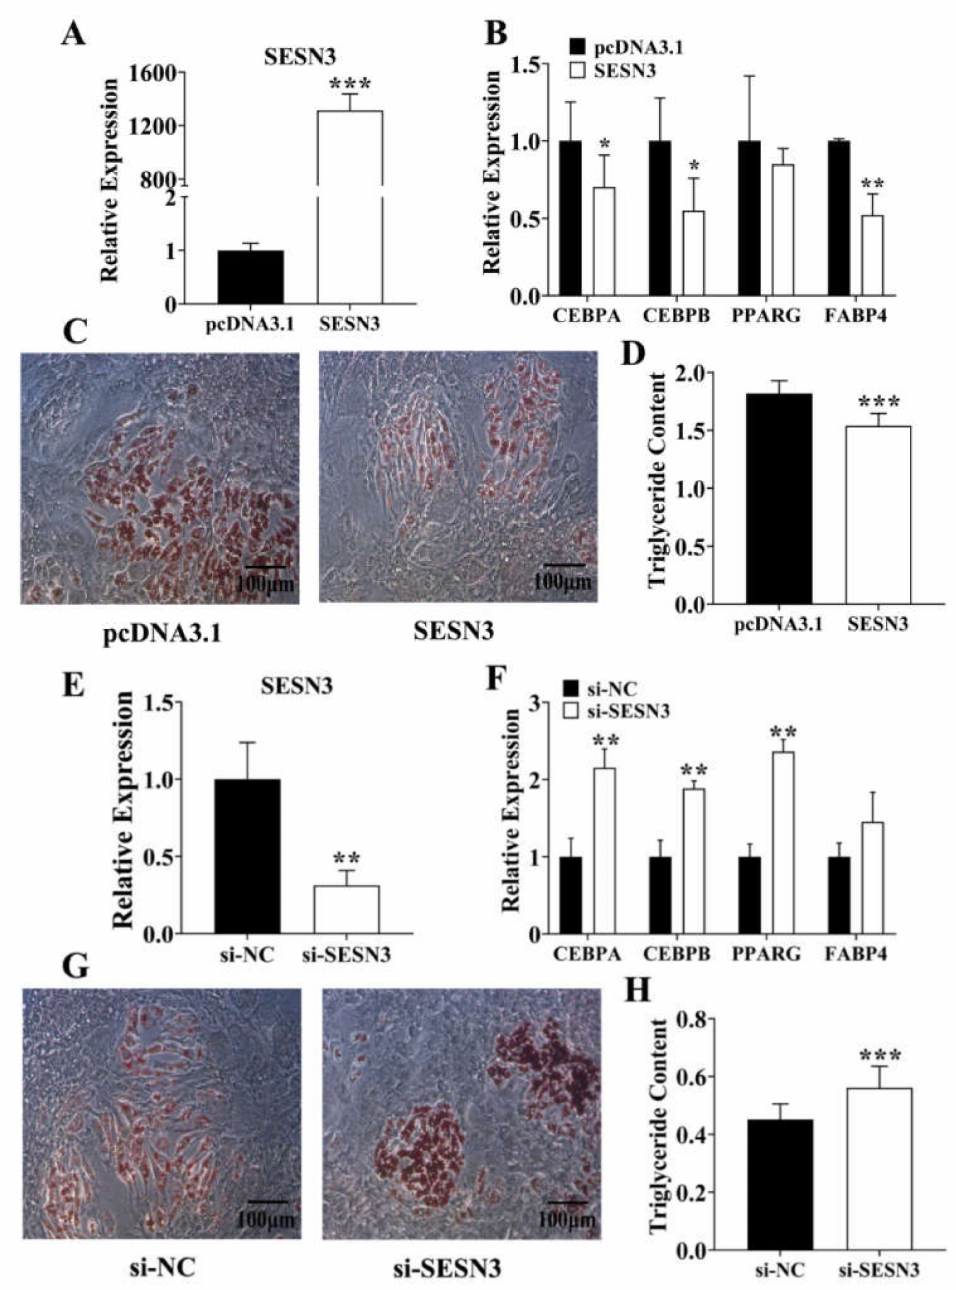
Figure 2. SESN3 inhibited pre-adipocyte adipogenesis. ( A ) Sesn3 was overexpressed in pre- adipocytes after transfecting pcDNA3.1-Sesn3-CDS vector. ( B ) The expression of adipogenic marker genes after transfecting pcDNA3.1-Sesn3-CDS vector into pre-adipocyte for 48 h. ( C , D ) The pre- adipocyte oil red O staining ( C ) and quantitation of total triglyceride result ( D ) after transfecting pcDNA3.1-Sesn3-CDS vector. ( E ) Sesn3 expression was inhibited after transfecting si-Sesn3. ( F ) The expression of adipogenic marker genes after transfecting si-Sesn3 into pre-adipocyte for 48 h. ( G , H ) The pre-adipocyte oil red O staining ( G ) and quantitation of total triglyceride result ( H ) after transfecting si-Sesn3. Data are presented as mean ± s.e.m. * means P < 0.05, ** means P < 0.01, and *** means P <